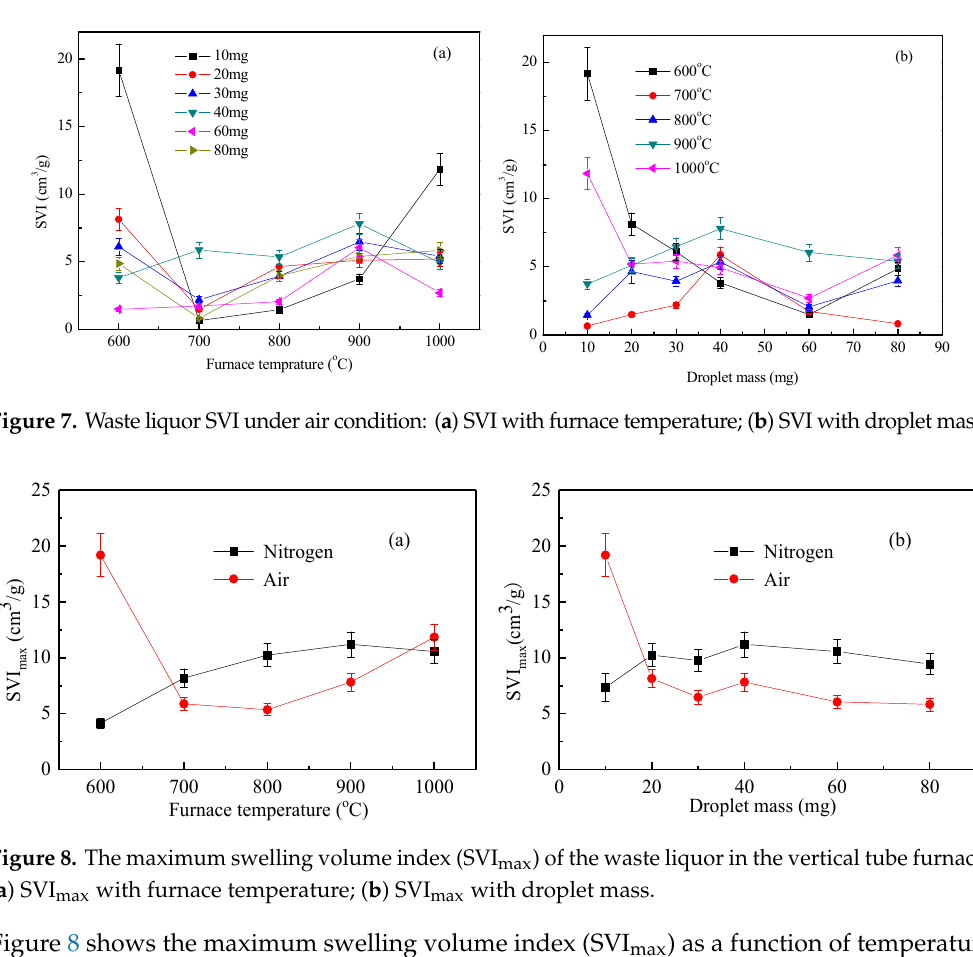
(b) Figure 6. Waste liquor swelling volume index (SVI) under nitrogen condition: ( a ) SVI with furnace temperature; ( b ) SVI with droplet mass. Figure 7 shows the distribution index of waste liquid expansion under an air atmosphere. The droplet expansion index decreased first and then increased with an increase in furnace temperature and decreased slightly with an increase in the droplet quality, but the amplitude was small. When the droplets were heated in an air atmosphere, the expansion characteristics of the waste liquid became complicated due to the participation of O 2 in the air, especially at high temperatures. Chemical reactions, including C/CO 2 , C/O 2 , and C/Na, were also considered [19,20]. During the test, no fire was observed when the furnace temperature was 600 °C. When the temperature was above 700 °C, an obvious flare was observed, indicating that the expansion process of the waste liquid at a high temperature was accompanied by a violent combustion reaction. When the furnace temperature was less than 600 °C, the expansion process of the droplets was mainly due to the evaporation of water and pyrolysis of the waste liquid, which caused the droplet volume to increase sharply [21]. However, when the droplet size increased, the specific surface area decreased, the heat transfer and mass transfer became slower, and the oxidation of the air formed a dense shell on the surface of the droplet, which hindered the volume expansion of the droplet. When the furnace temperature was 700–1000 °C, the droplet evaporation and small molecule evaporation analysis time was very short—that is, by entering the macromolecular pyrolysis stage, a large amount of gas was